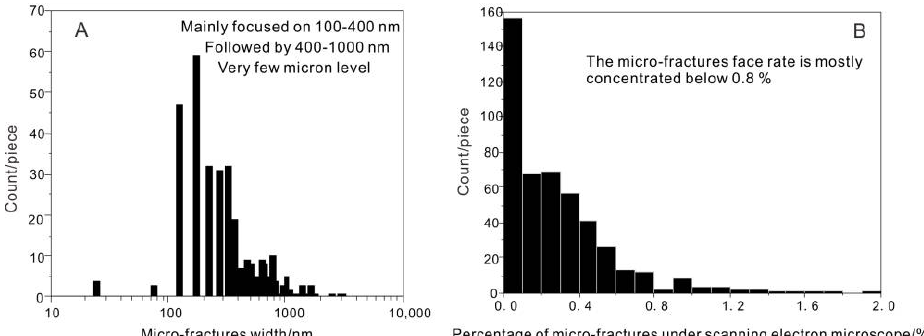
Figure 9. Statistical graph of we have observed numerous micro-scale fractures width under scanning electron microscope ( A ), and statistics of micro-crack face rate under scanning electron microscopel ( B